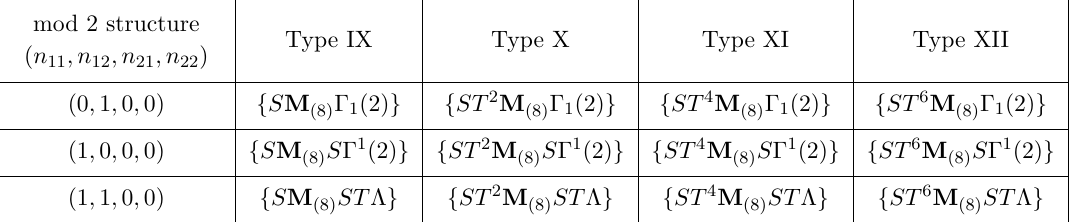
Table 20 . Classification of Types IX, X, XI, XII for D = 8 .